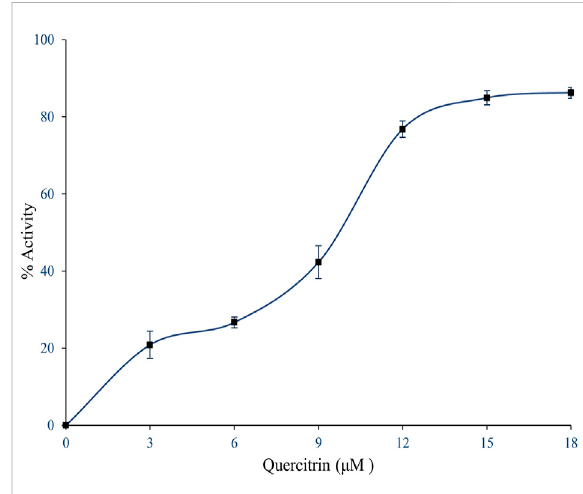
FIGURE 2 Inhibition of sPLA 2 IIa enzyme by quercitrin. In brief, 350 µl reaction mixture consists of 3.18×10 9 autoclaved E. coli cells, 5 mM calcium, and 100 mM Tris – HCl buffer pH 7.4 with sPLA 2 IIa enzyme and indicated concentration of inhibitors, incubated at 37 ° C for 60 min. The sPLA 2 IIa activity was estimated by measuring 14 C radiation using the Quantulus 1220 liquid scintillation spectrometer. sPLA 2 IIa inhibition was noted as a percentage of control and the IC 50 value was found to be 8.77 μ M ± 0.9. The data showed mean ± SD ( n = 3).